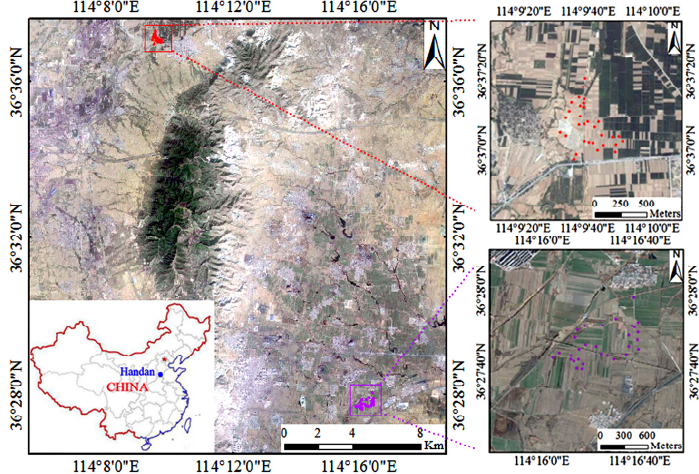
Figure 1. Study area and sampling sites. The upper right and lower right figures represent the Wannian and Jiulong experimental areas, respectively. The round dots indicate the sampling sites.